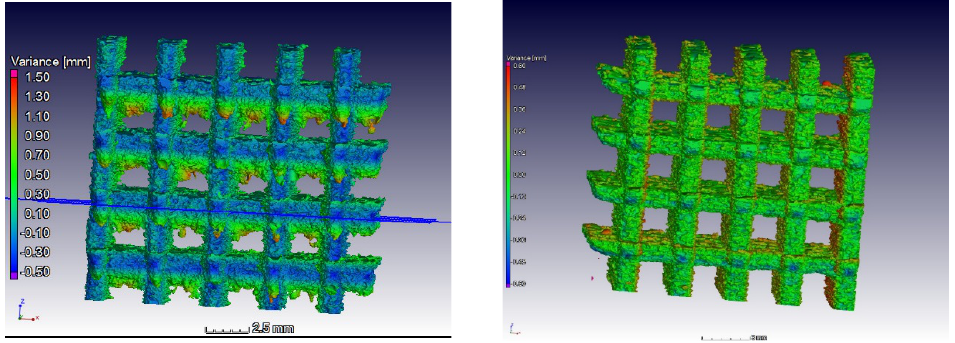
Figure 16. Degree of variance from original STL file (1 mm strut): standard ( left ) and modified ( right ) scan strategies.